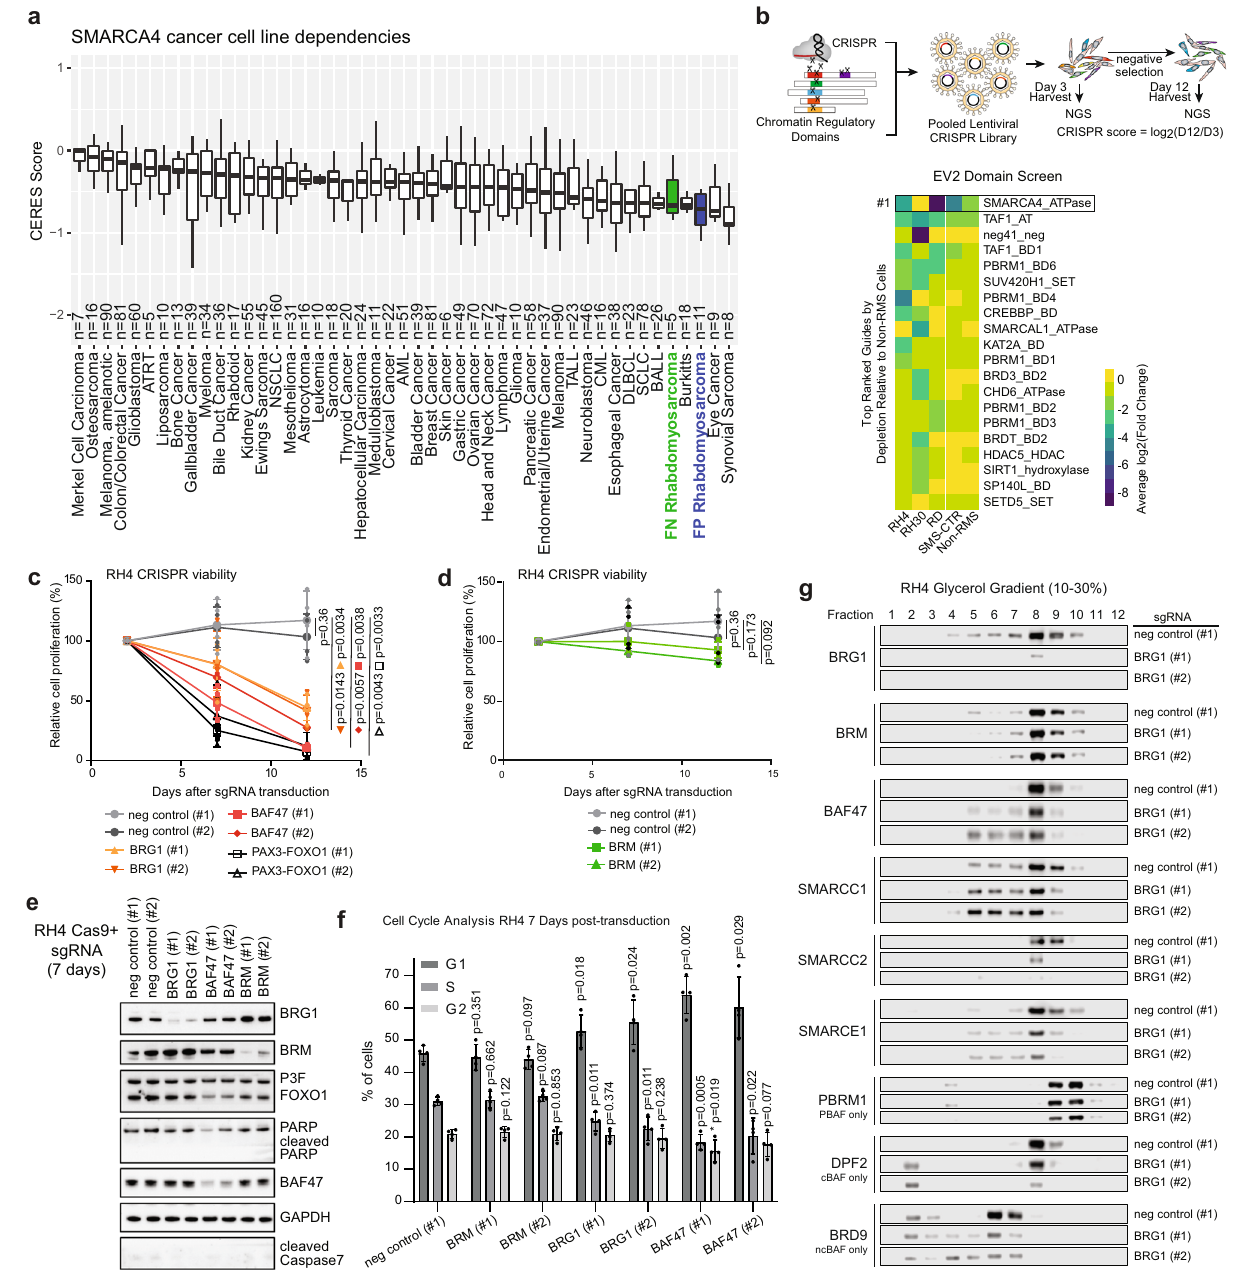
Fig. 1 mSWI/SNF complexes are essential in fusion-positive rhabdomyosarcoma. a Data from DepMap was analyzed to determine the relative dependence of RMS cells on BRG1 (encoded by SMARCA4) compared to other cancer cell line disease types ( n = sample number). Box plots of median and quartiles, with whiskers showing 1.5 × inter-quartile ranges. b A CRISPR screen targeting catalytic chromatin regulatory domains was performed in FP- RMS cells (RH4 and RH30), FN-RMS cells (RD and SMS-CTR) cells, and non-RMS control cell lines. Fold depletion values in all cell types were directly compared and guides were ranked by speci fi c depletion in RMS vs. non-RMS cells. c , d Relative cell proliferation (%) of Cas9 expressing RH4 cell populations transduced with indicated sgRNAs determined by fl ow cytometry. Data points represent the evolution of transduced cell populations compared to untransduced cells in co-culture. Values are normalized to the starting point of the experiment (day 2 after transduction). Mean and standard deviation values are indicated for four independent biological replicates. Statistical signi fi cance is given for the endpoint of the experiment (day 12 after transduction) by paired t -tests (two-tailed). e Western blot analysis of whole cell lysates 7 days after transduction of Cas9 expressing RH4 cells with indicated sgRNAs. f Cell cycle effects measured 7 days after transduction of Cas9 expressing RH4 cells with indicated sgRNAs by means of PI staining. Mean and SD values are given for at least four different biological replicates. Statistical signi fi cance is given compared to negative control by paired t -tests (two-tailed). g Glycerol gradient (10 – 30%) sedimentation assays were performed on nuclear extracts from Cas9-RH4 cells harvested 7 days after transduction with the indicated